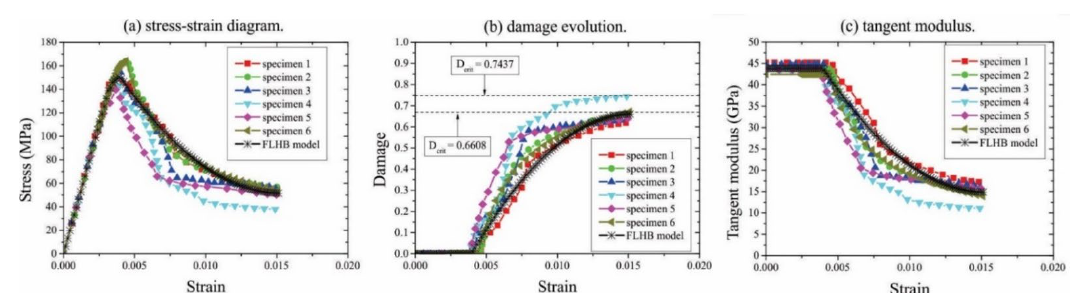
Figure 2. Axial compression at room temperature of UHPFRC with 2% of fibers [30]: (a) stress-strain diagram; (b) damage evolution and (c) tangent